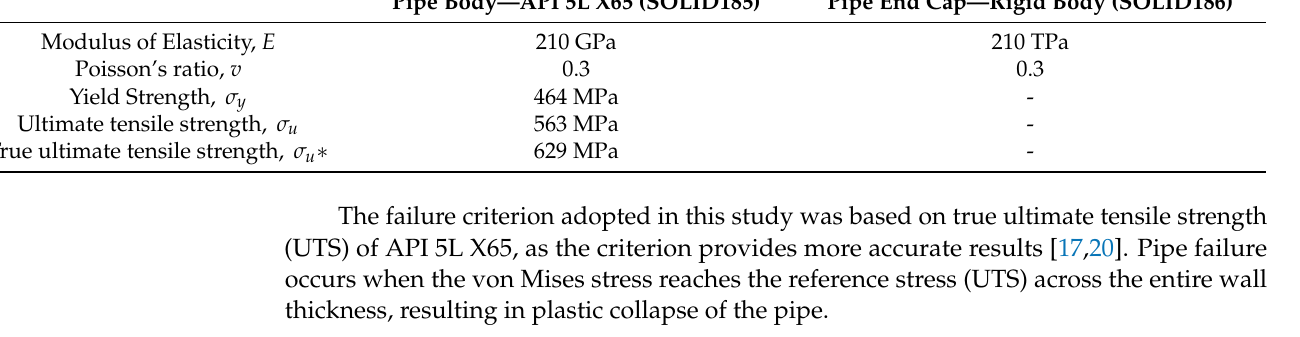
Figure 4. True stress–strain curve of API 5L X65 pipeline [25].